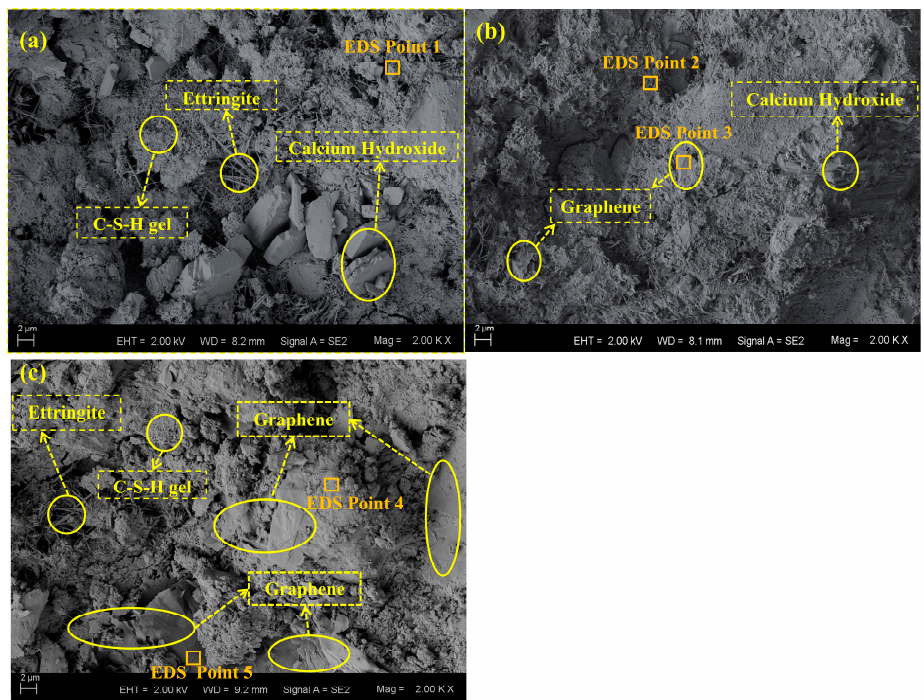
Figure 7. SEM graphs of composites ( a ) without graphene, ( b ) 0.8% graphene content, and ( c ) 1.8% graphene content. Table 5. Element compositions based on the EDS analysis.